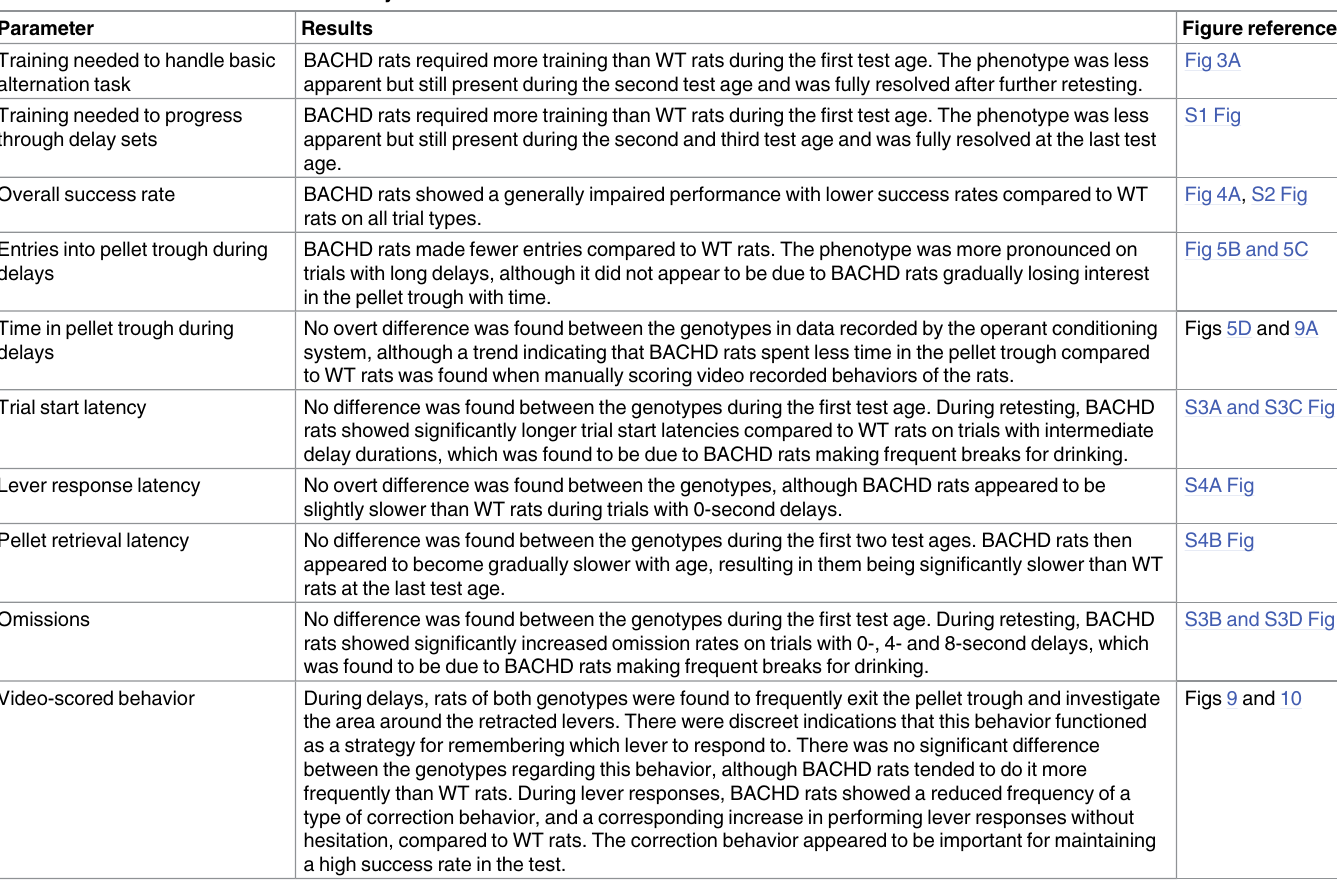
Table 1. Overview of results from the delayed alternation test. Parameter Results Training needed to handle basic alternation